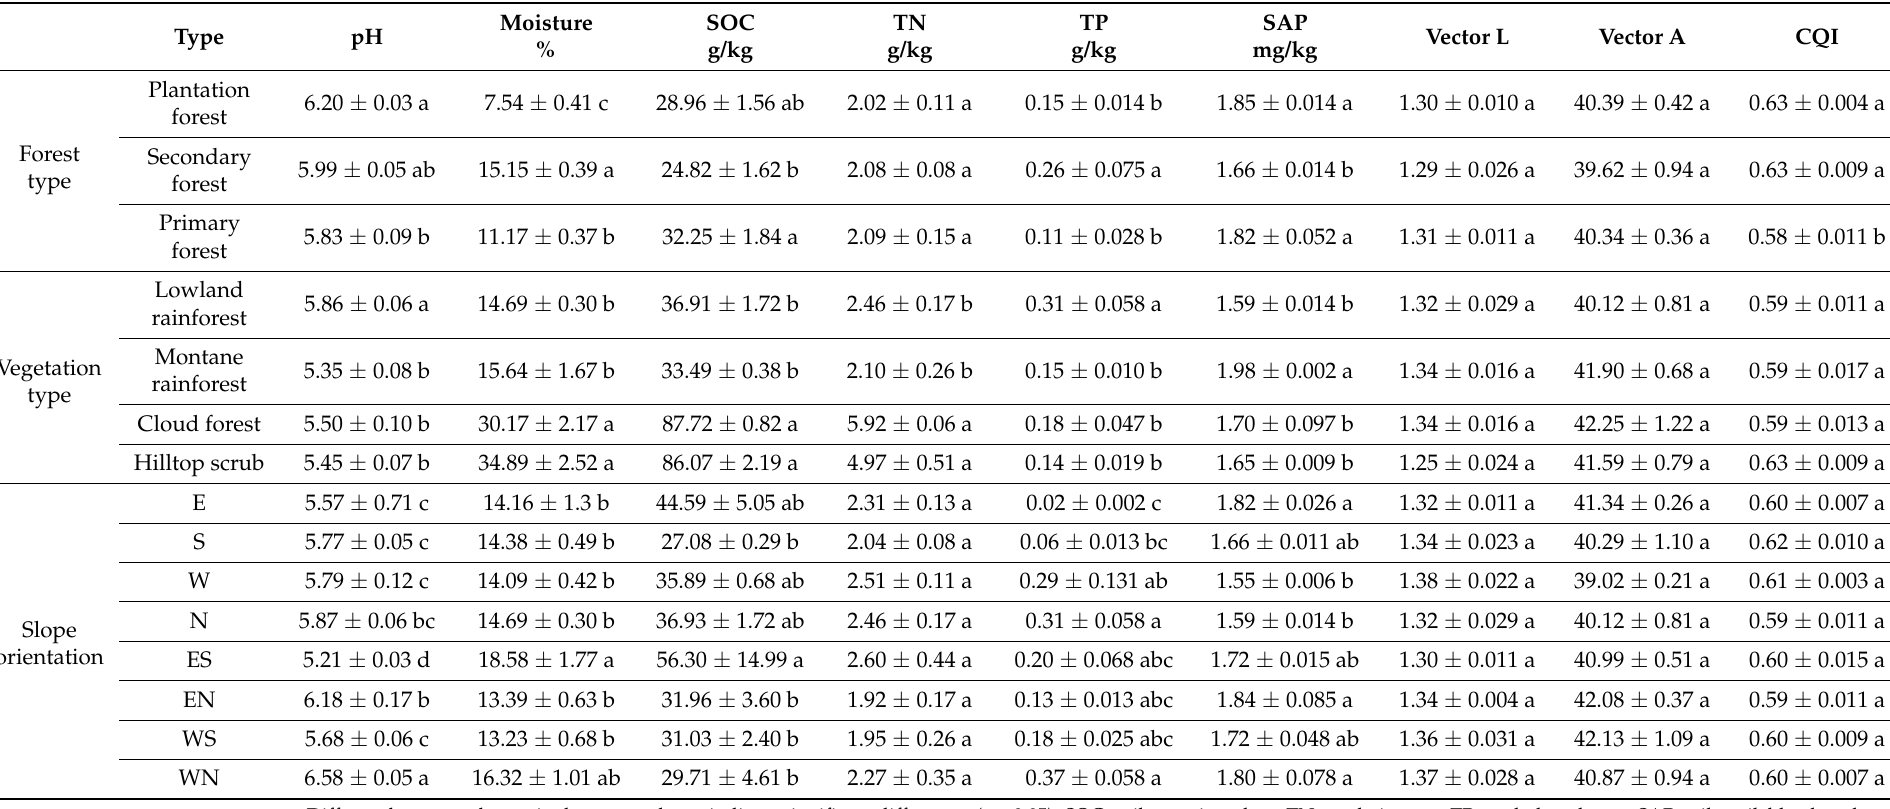
Table 1. Physicochemical properties of soils of different forest types, vegetation types, and slope orientations in the Wuzhishan National Nature Reserve. The numbers are means ± standard error. The letters in lowercase indicate significantly different groups based on Duncan’s multiple comparison ( p =